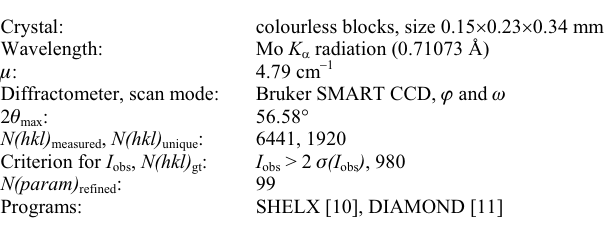
Table 1. Data collection and handling.